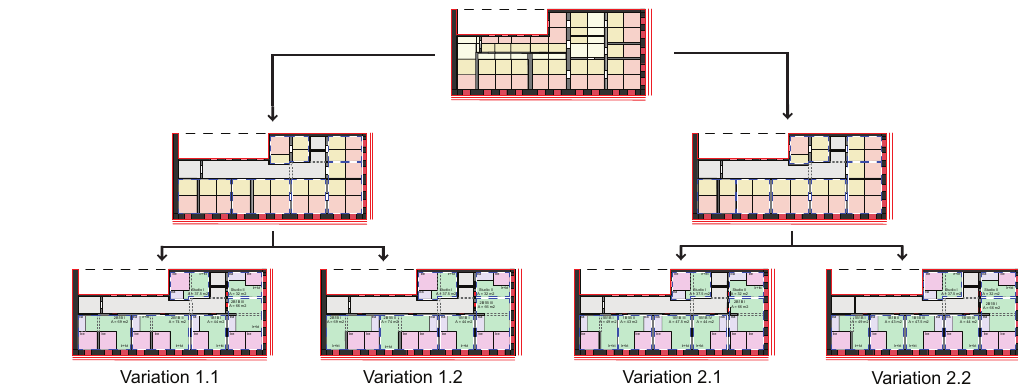
Figure 15. Variation process for the case study building 2.